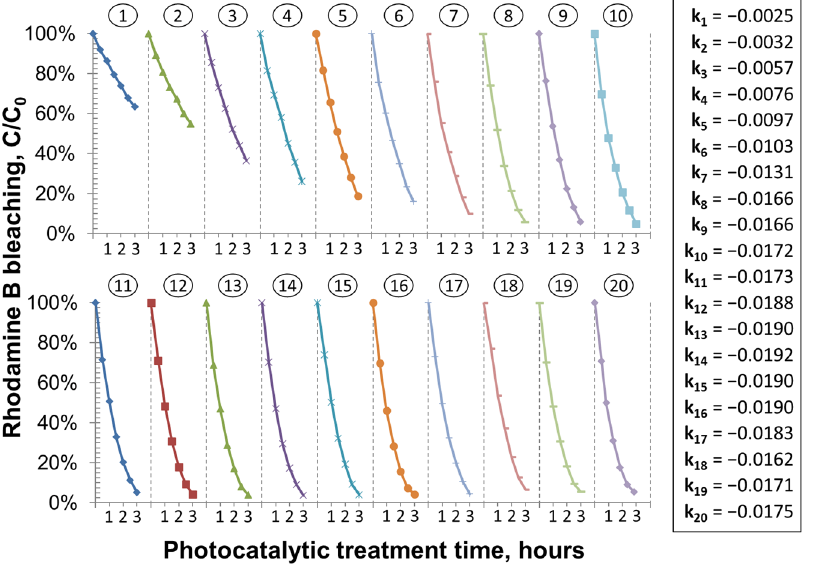
Figure 8. Evolution of C-TiO 2 +Ni MP activity over 20 consecutive RhB solution bleaching cycles under visible light irradiation. Circled numbers above the curves indicate cycle order, whereas k values represent first order reaction constants (in min − 1 units) of the corresponding cycles.